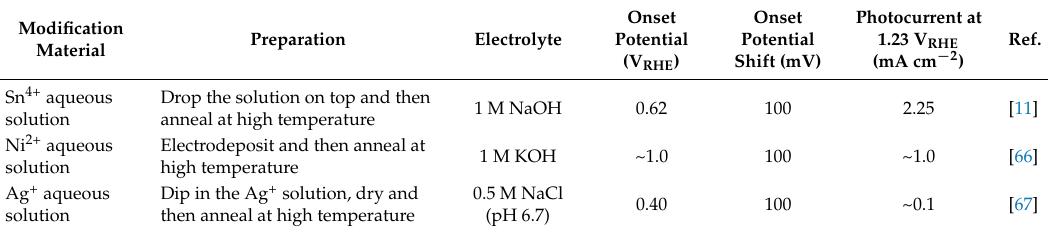
Dip in the Ag + solution, dry and then anneal at high